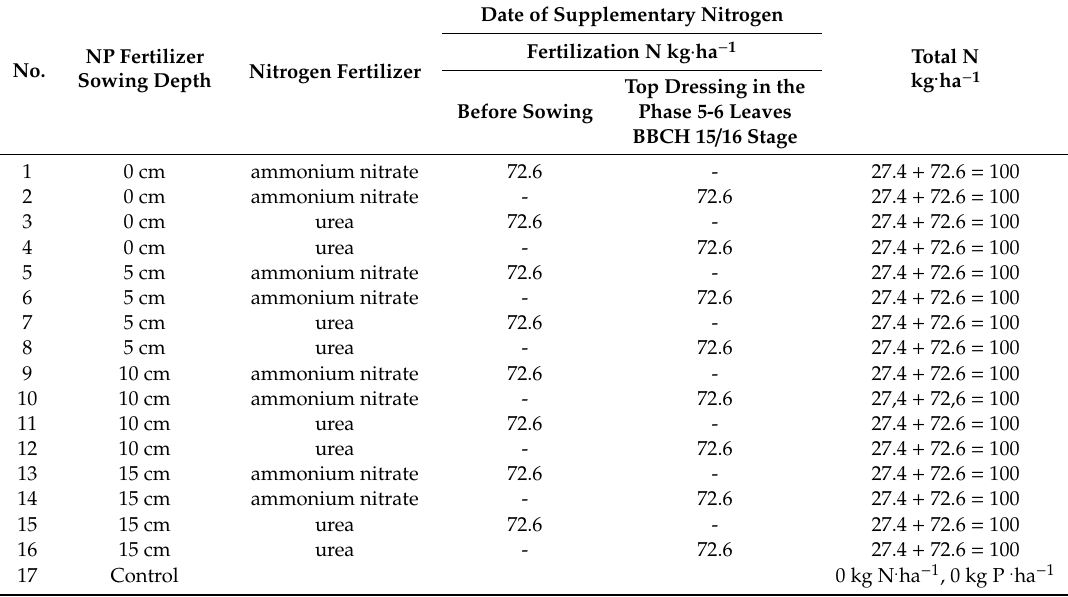
Table 1. Scheme of nitrogen fertilization in the experimental field (kg · ha − 1 ).